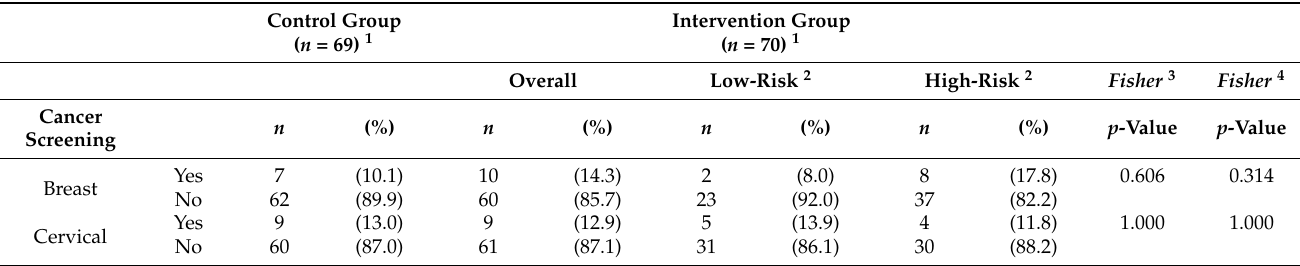
Table 3. Participation in gynecological cancer screening during the follow-up period, stratified by intervention and total genetic risk.